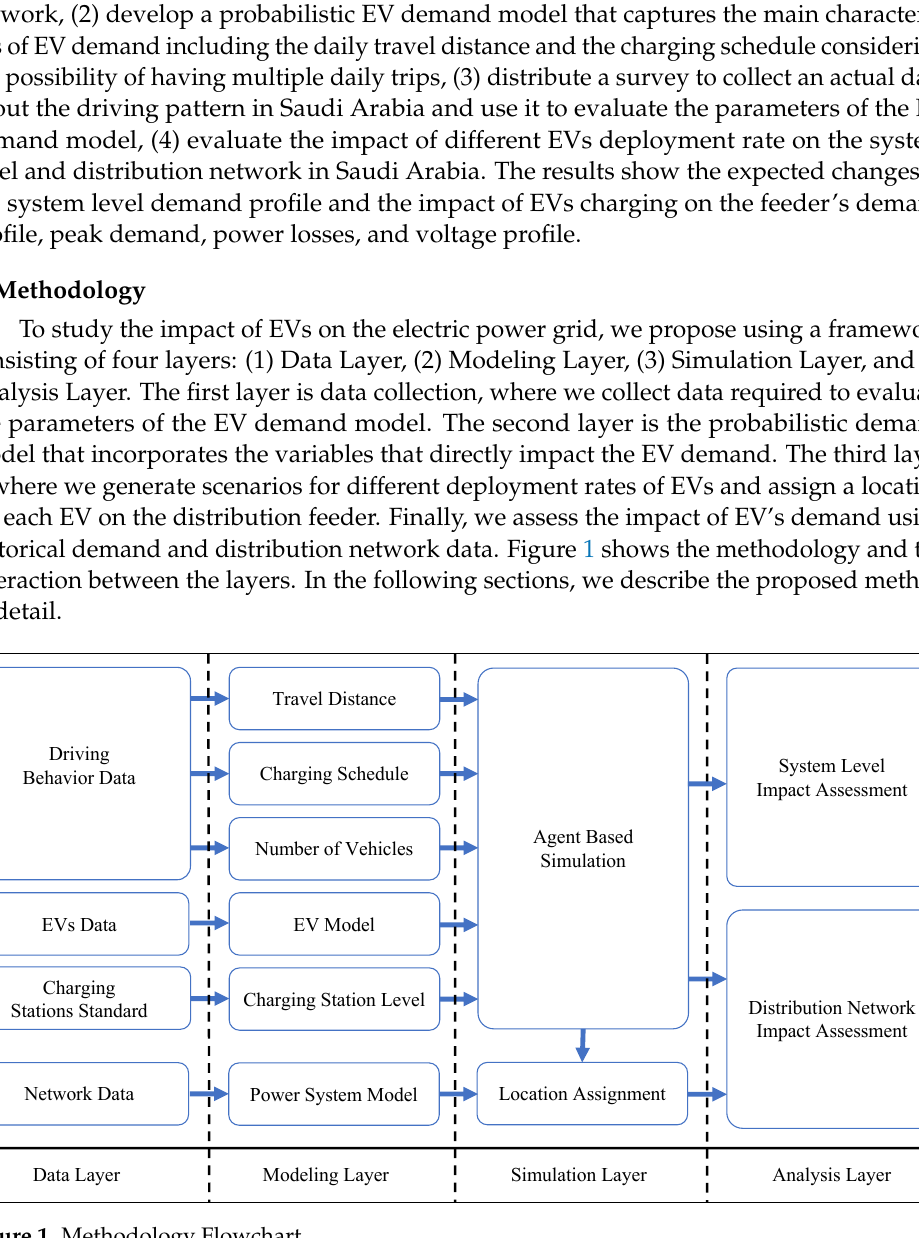
Figure 1. Methodology